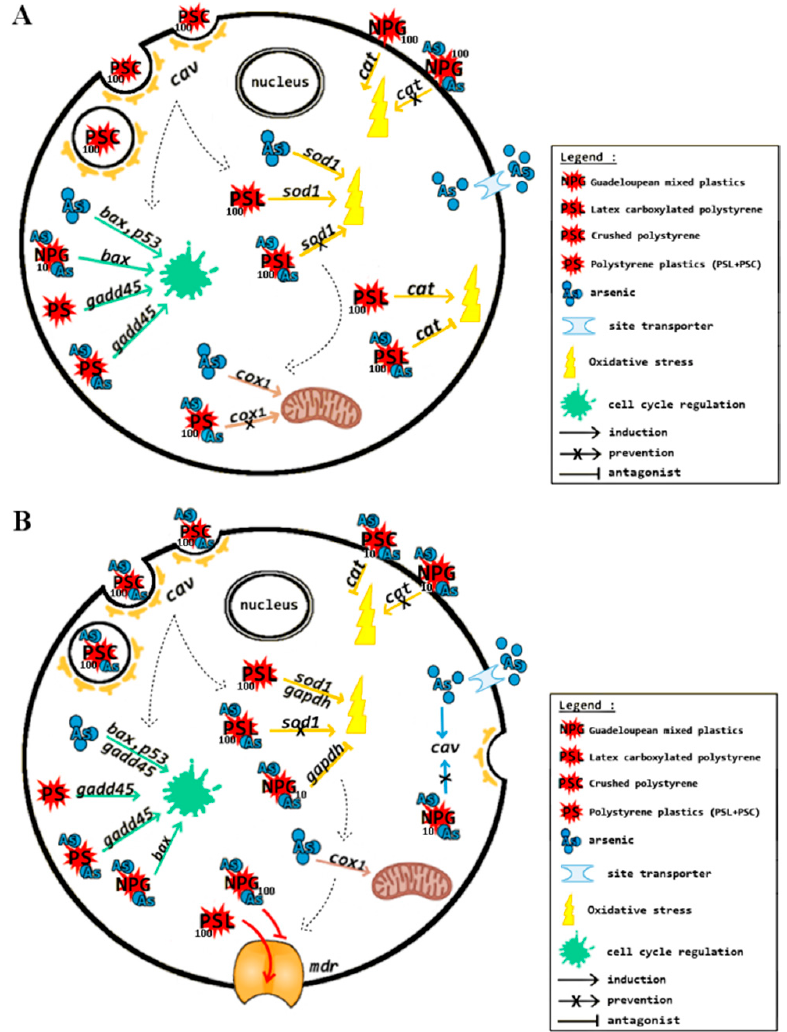
Figure 4. Schematics of suggested cellular effects of NPs and As in I. alatus’ gills ( A ) and visceral mass ( B ) tissues.